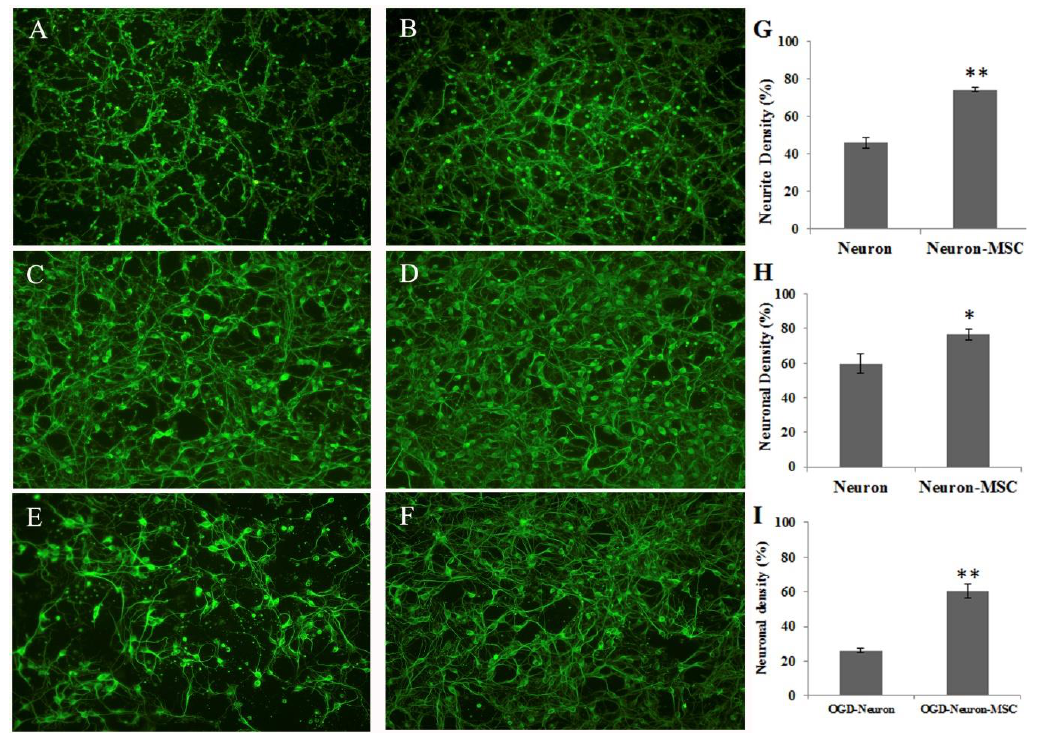
Figure 1. Beneficial effect of MSC co-cultures on neuronal connection and survivals. ( A ) Extended neurite of neuron–glial cultures through transwell. ( B ) Extended neurite of neuron–glial cultures through transwell in the presence of MSC cocultures. ( C ) Neurite outgrowth of neuron–glial cultures, grown on culture plate. ( D ) Neurite outgrowth of neuron–glial cultures in the presence of MSC-seeded transwell. ( E ) OGD-treated neuron–glial cultures, grown on culture plate. ( F ) OGD-treated neuron–glial cultures in the presence of MSC-seeded transwell. ( G ) Quantification of neurite outgrowth of A and B. ( H ) Quantification of neuronal density of C and D. ( I ) Quantification of neuronal density of E and F. Data represent the mean ± SEM. * p < 0.05, ** p < 0.01, indicates significant difference between neuron–glial cultures and cocultures of neuron–glia and MSC.